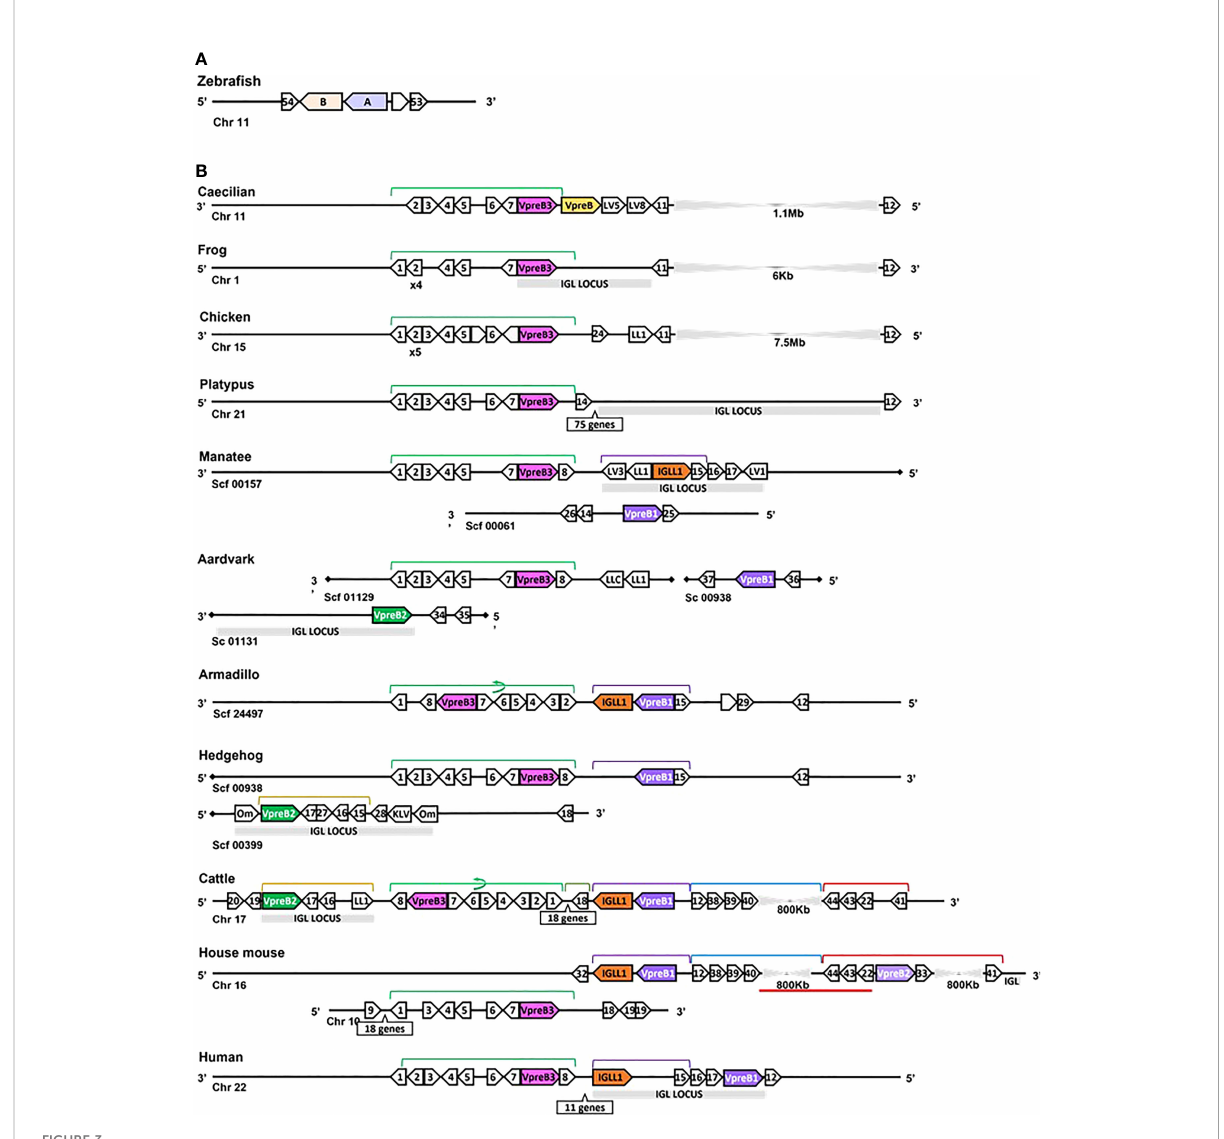
FIGURE 3 Locus synteny of VpreB3 and surrogate light chain (VpreB1, VpreB2, IGLL1) genes in tetrapod vertebrates. (A) Putative orthologs of both VpreB ( A : sid1 , light purple) and IGLL1 (light orange, B : si:ch211-1a19.2 ) in the zebra fi sh ( Danio rerio ) genome (B) In tetrapod vertebrates, relevant genes are shown in pink (VpreB3), purple (VpreB1), green (VpreB2), and orange (IGLL1). Polygons containing syntenic genes found in two or more species contain a number corresponding to the gene name. Polygons containing genes for uncharacterized proteins are empty. A solid line represents contiguous genomic sequence (chromosome or unplaced scaffold) and is denoted by the chromosome (Chr) or scaffold (Scf) to which it belongs. A line ending in a diamond shape indicates the end of a chromosome or scaffold and no further genes occur in that direction. Orientation of chromosomes or scaffolds is indicated by the 5 ’ or 3 ’ labels at the ends of the solid lines, and gene polygons point in their transcriptional direction. We indicate blocks of syntenic genes with the number of genes in a box below the line and long, unaligned regions with the genomic distance between syntenic genes. Colored lines above the polygons denote syntenic gene blocks, and lines containing an arrow indicate the syntenic block is inverted compared to caecilian. A red line below the polygons indicates an insertion of non-syntenic genes. The location of the lambda light chain locus (IGL, if present) is indicated by a gray rectangle. Orthologs between species are aligned vertically, but distances are not to scale. Polygons containing variable segments of lambda (LV) or kappa (KV) light chains and those containing lambda constant regions (LL) are reported with the annotated V or C segment number. In hedgehog, “ Om ” refers to the annotated gene omega , an alternate gene card name for VpreB2, that do not encode the VpreB2 protein. All other gene names are denoted by a number within the polygon (Polygon #: Gene name 1: MIF ; 2: SLC2A11 ; 3: DERL3 ; 4: SMARCB1 ; 5: MMP11 ; 6: CHCH210 ; 7: C22orf15 ; 8: ZNF70 ; 9: RGL4 ; 10: PDCH15 ; 11: CA15L ; 12: TOP3B ; 13: BABAM1 ; 14: OAS1 ; 15: PRAME ; 16: ZNF280A ; 17: ZNF280B ; 18: SGLT1 ; 19: SLC5A4 ; 20: SLC5A1 ; 21: FDG4